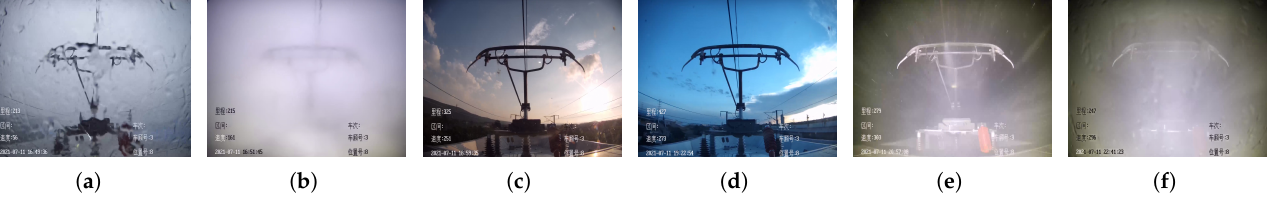
Figure 29. Scenes taken at different moments of the same HSR in rainy weather. ( a ) Case I. ( b ) Case II. ( c ) Case III. ( d ) Case IV. ( e ) Case V. ( f ) Case VI. Table 4. Performance of the same HSR at different times with different levels of